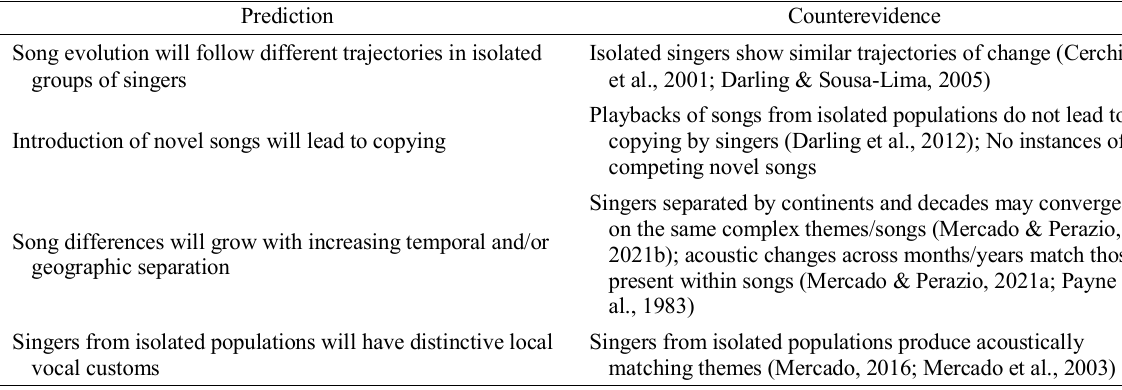
The Case Against the Vocal Culture Hypothesis in Humpback Whales Prediction Counterevidence Song evolution will follow different trajectories in